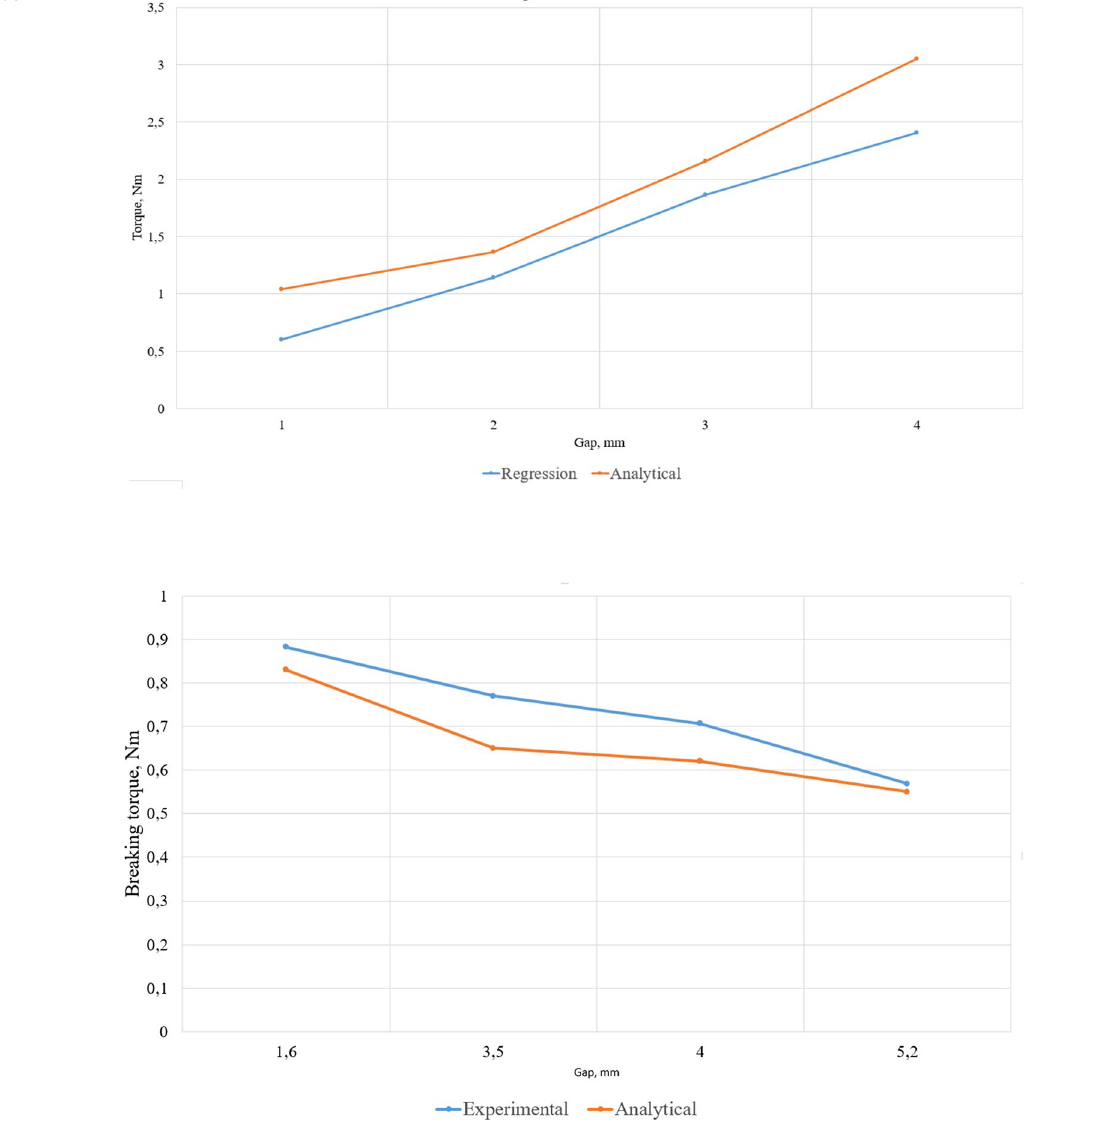
Fig. 9 Comparison of math- ematical models